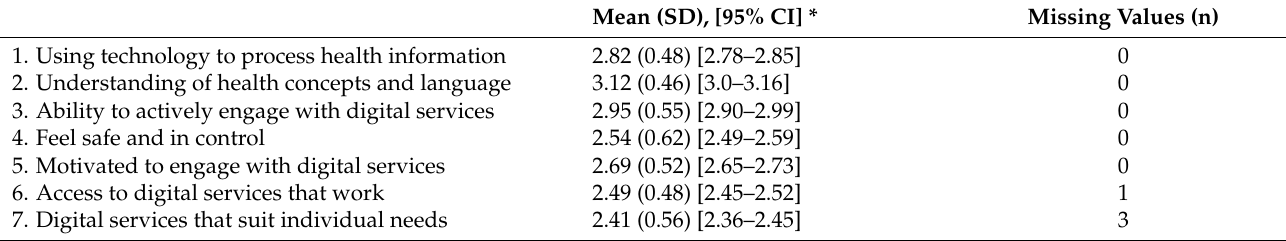
Table 2. eHLQ scores for overall sample (score range: 1 (lowest) to 4 (highest). Mean (SD), [95% CI] * Missing Values